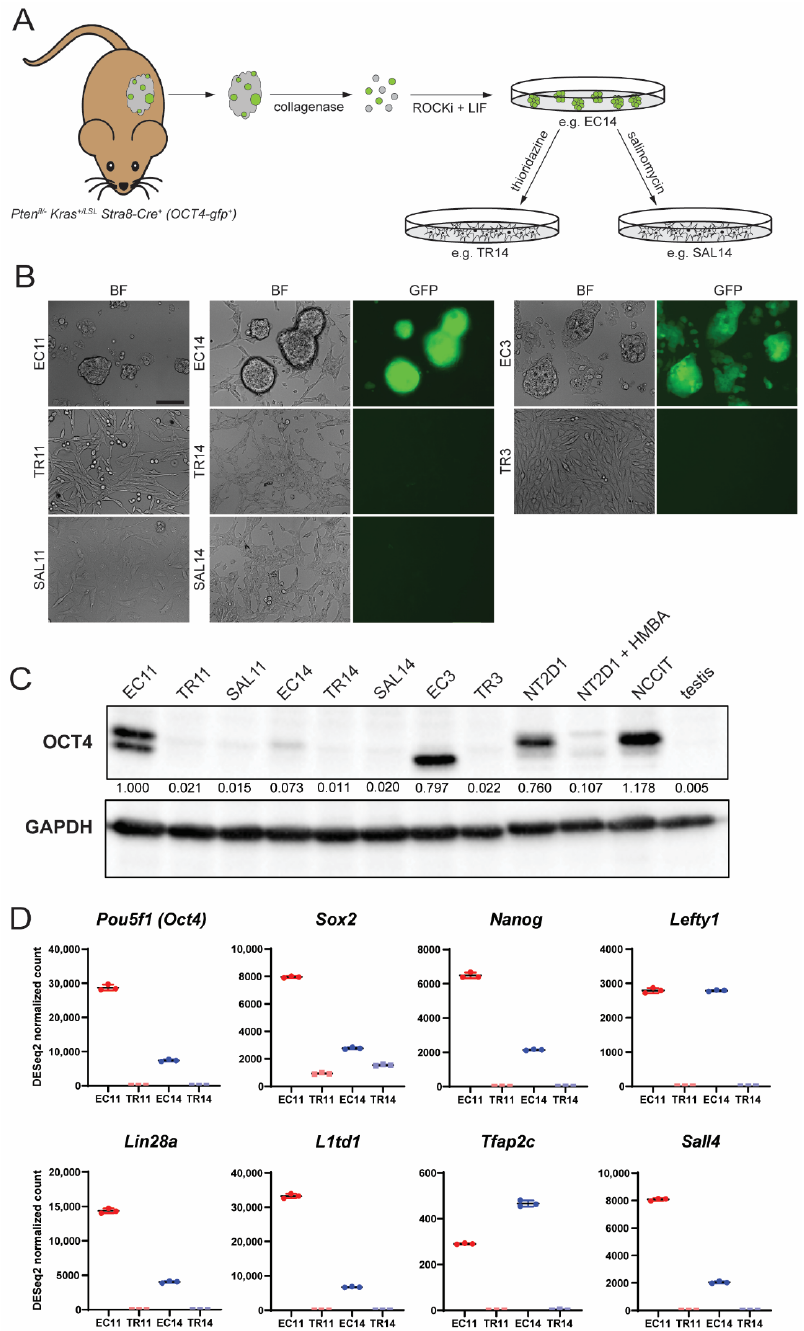
Figure 1. Treatment of murine EC cells with thioridazine or salinomycin alters cell morphology and decreases expression of pluripotency markers. ( A ) Derivation of murine EC cell lines from spontaneous malignant teratocarcinomas in gPAK mice. ( B ) Bright field and fluorescence images of three independent EC cell lines (EC11, EC14, and EC3), two of which carry an OCT4-gfp transgene (EC14 and EC3), before and after thioridazine (TR11, TR14, and TR3)- or salinomycin (SAL11 and SAL14)-mediated differentiation. Scale bar = 100 μ m. ( C ) Western blot showing OCT4 protein expression (OCT4A and OCT4B isoforms) in murine EC cell lines, their thioridazine- and salinomycin- differentiated derivatives, human EC cell lines NT2D1 and NCCIT, HMBA-differentiated NT2D1 cells, and murine testis tissue. Densitometry values were normalized to GAPDH (loading control) and expressed as a proportion of the first lane. ( D ) DESeq2 normalized count values from RNASeq data for eight pluripotency-associated genes. Data are mean values ± standard deviation, n = 3 independent replicates per